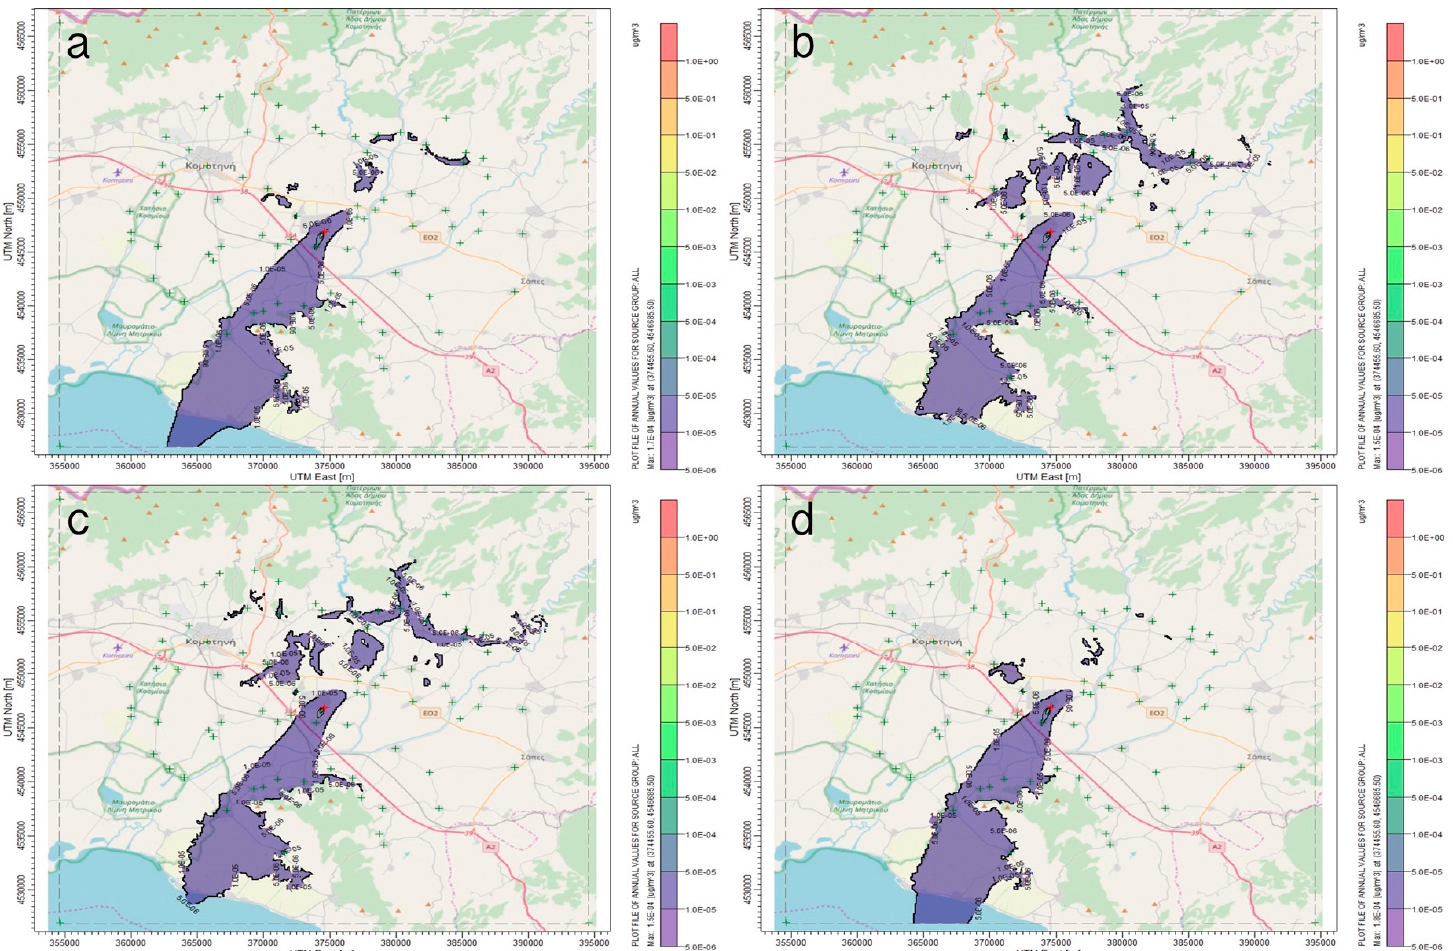
Figure 2. Annual average concentration of TSP of Pb ( µ g m − 3 ) for ( a ) the typical operating conditions for 2015, ( b ) the typical operating conditions for 2016, ( c ) the typical operating conditions for 2017, and ( d ) the typical operating conditions for 2018.